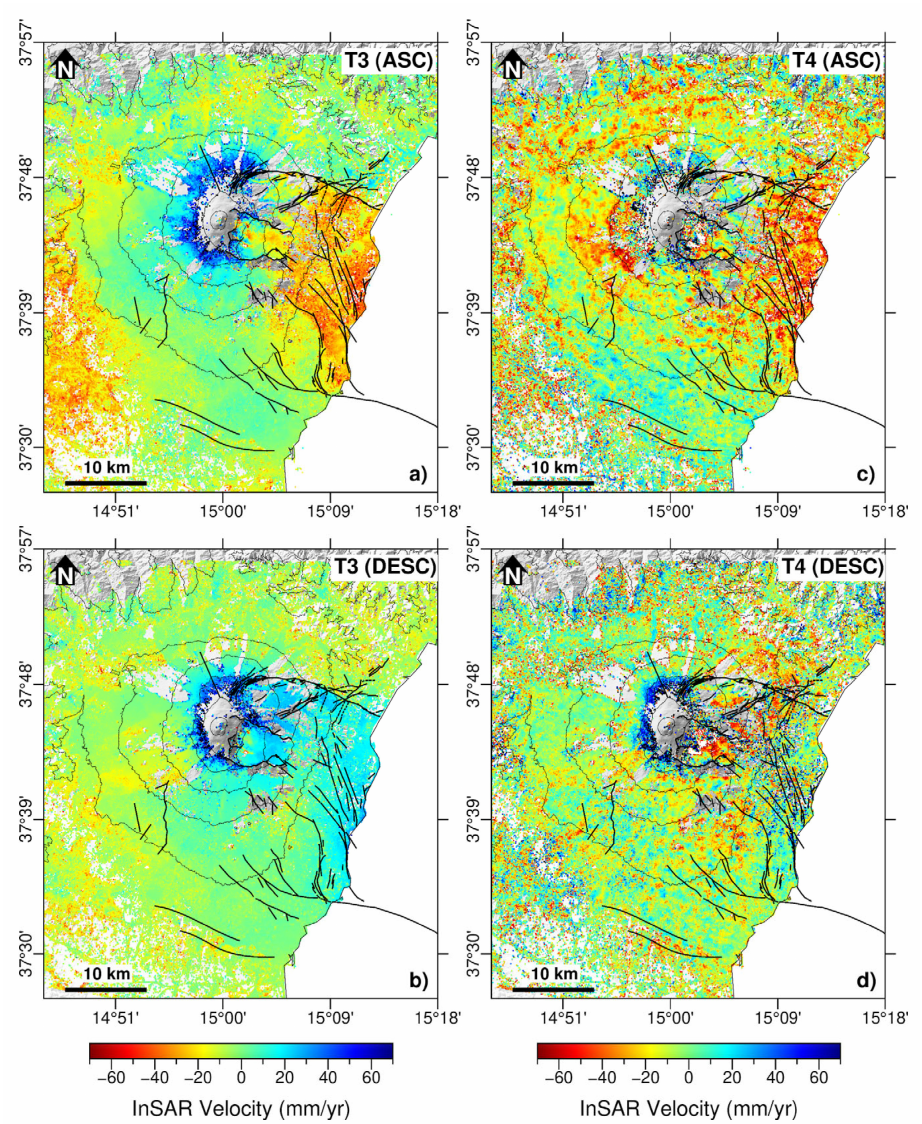
Figure 4. Ascending (panels a , c ) and descending (panels b , d ) velocity maps relative to T3 (2 June 2019– 15 February 2021) and T4 (15 February 2021–29 March 2021) time intervals. Positive values (blue colors) represent scatterers approaching the satellite, negative values (red colors) are moving away. Main faults are also reported as black